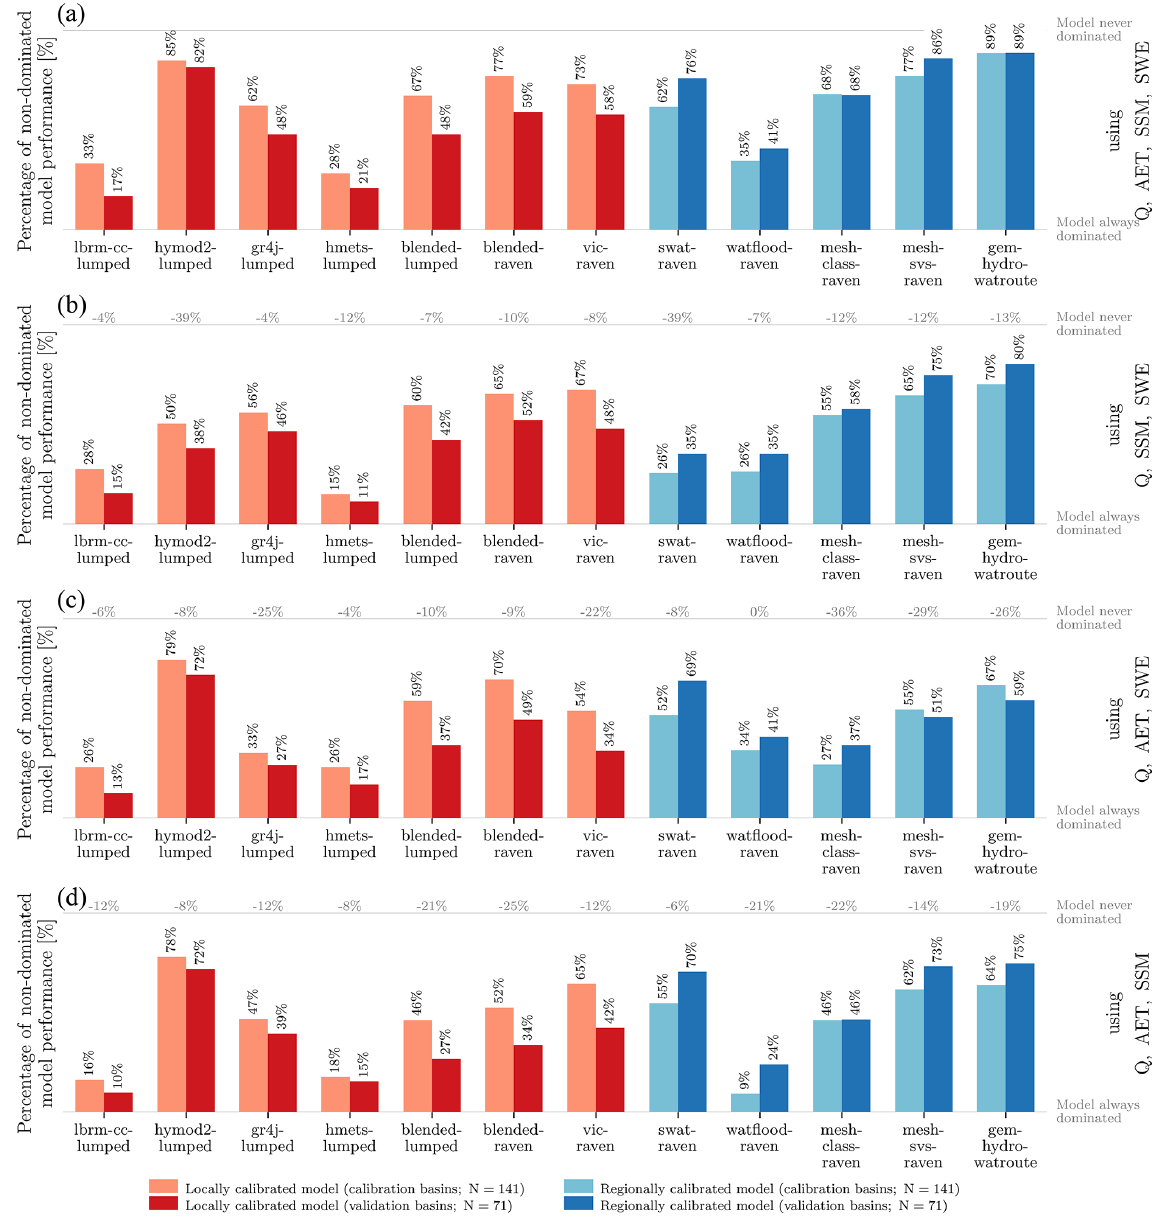
Figure 8. Multi-objective analysis of model performances. The 12 models ( x axis) that provided streamflow ( Q ) simulations and results for the three additional variables – actual evapotranspiration (AET), surface soil moisture (SSM), and snow water equivalent (SWE) – are analyzed using a multi-objective analysis to determine the number of times a model is superior in at least one of the considered performance metrics. This measure of non-dominance ( y axis) is derived using (a) all four variables ( Q , AET, SSM, and SWE), (b) considering all variables but not AET, (c) all variables but not standardized SSM, and (d) all variables except SWE. The metrics are derived for time periods not used during calibration, i.e., 2011 to 2017 for streamflow and 2001 to 2017 for all other variables. The estimates are derived using the basin-wise performances presented in Figs. 3 and 4. The derived percentages of non-dominance are added as labels above each bar in black. The percentages are derived for calibration basins (lighter colored bars) and validation locations (darker shaded bars). Panels (b–d) additionally show a gray labeled percentage value on top of the gray horizontal line, which indicated perfect model skill. Those gray- colored percentage values indicate how the model skill changed compared to the skill when all four variables are used ( panel a) . The models are grouped into models that locally calibrated each basin independently (red bars) and models that calibrated all locations of each region simultaneously (blue